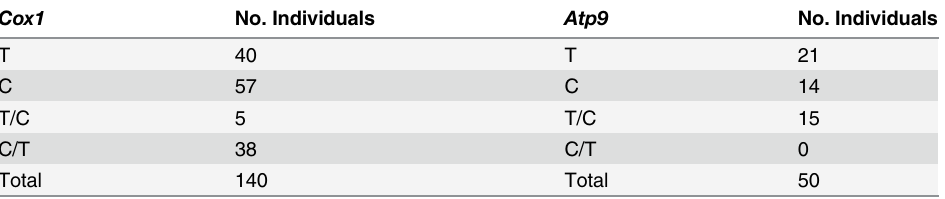
Table 3. Summary genotype counts for Cox1 and Atp9 as given by either homoplasmic T or C and het- eroplasmic T/C or C/T where the major SNP is listed first. Cox1 No. Individuals